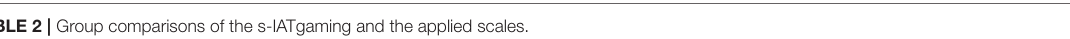
TABLE 2 | Group comparisons of the s-IATgaming and the applied scales. Female participants ( n = 43) Male participants ( n = 59) Group